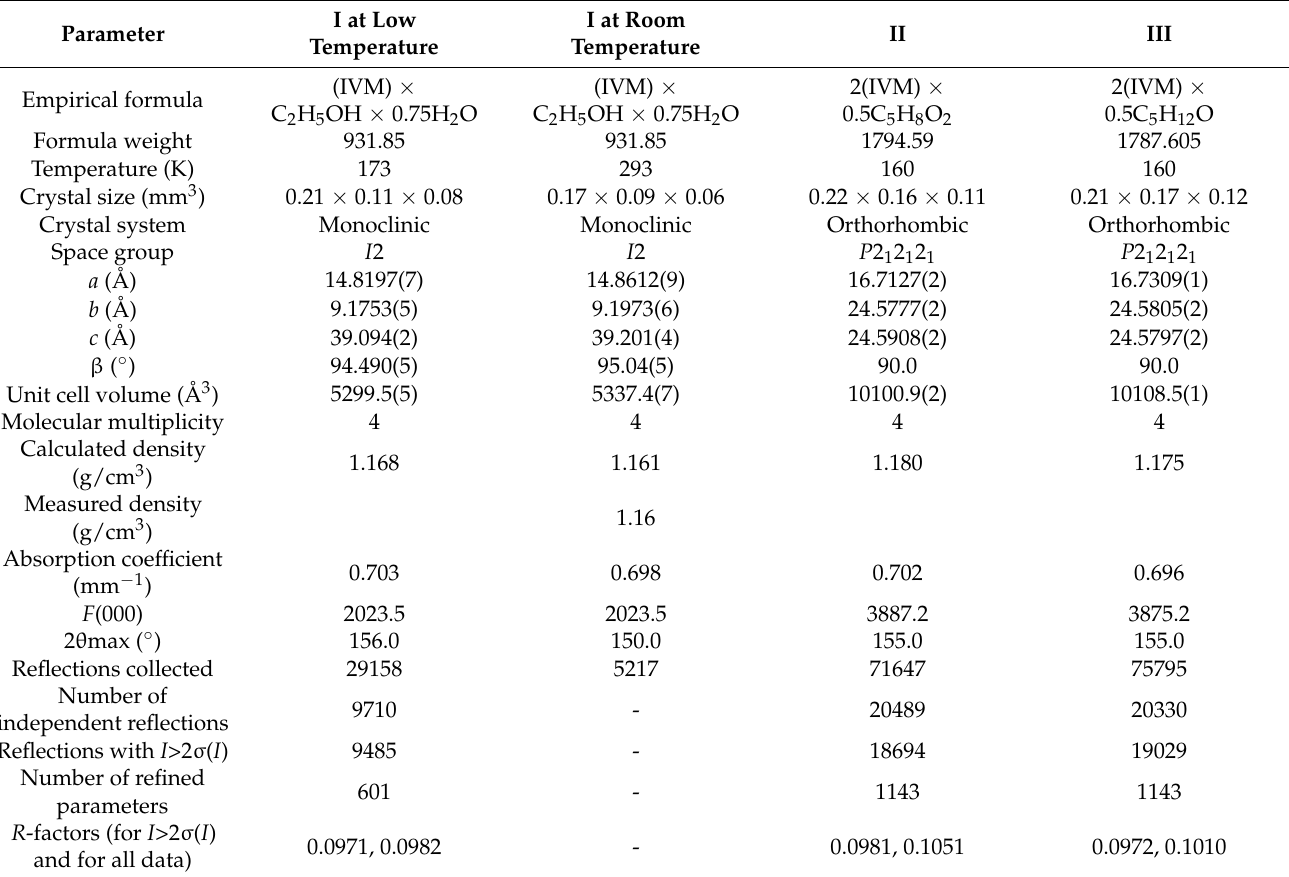
Table 1. Crystal data and structure refinement parameters for solvates I , II and III 1